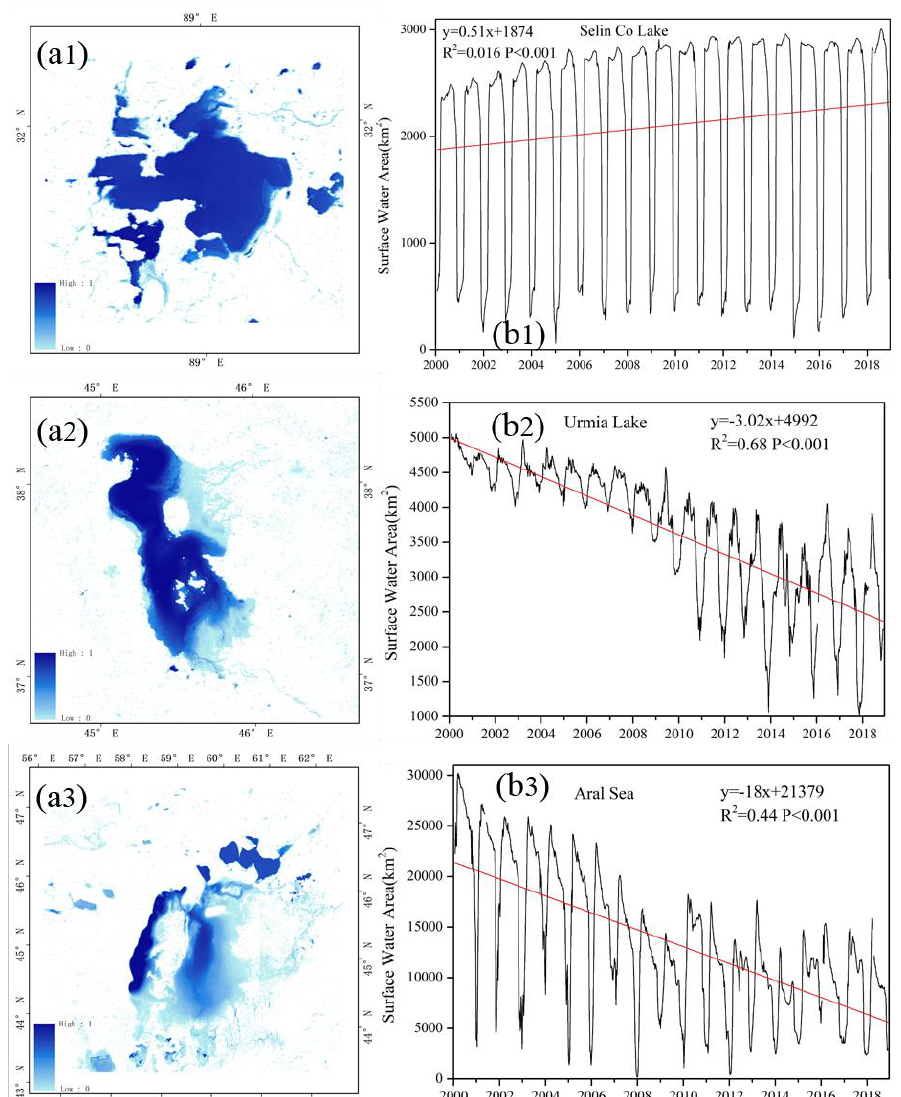
Figure 8. Water occurrence of Selin Co Lake ( a1 ), Urmia Lake ( a2 ), and the Aral Sea ( a3 ); water areal changes of Selin Co Lake ( b1 ), Urmia Lake ( b2 ), and the Aral Sea ( b3 ) from 2000 to 2018.